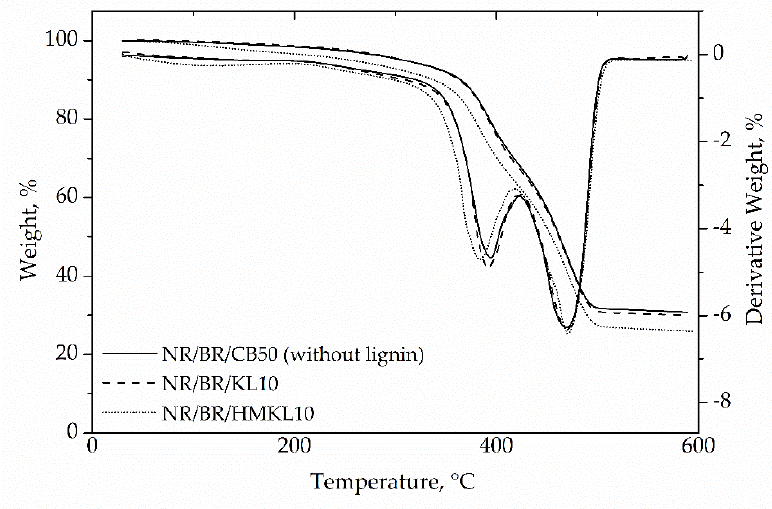
Figure 15. The effect of HMKL content on the thermal stability, thermogravimetric analysis (TGA), and derivative weight loss (DTG) of lignin-filled NR/BR compounds.